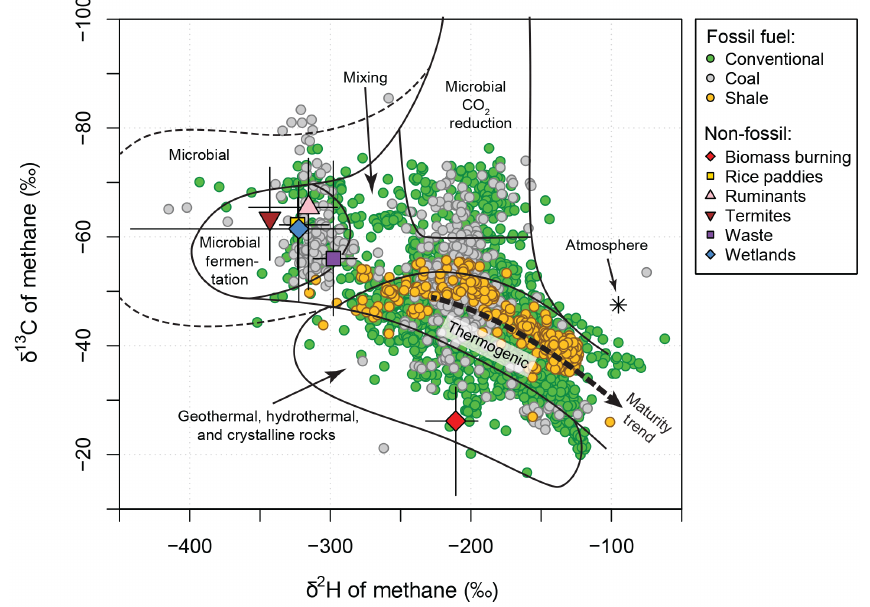
versus δ 2 H CH showing data distributions with respect to genetic domains, as traced 4 4